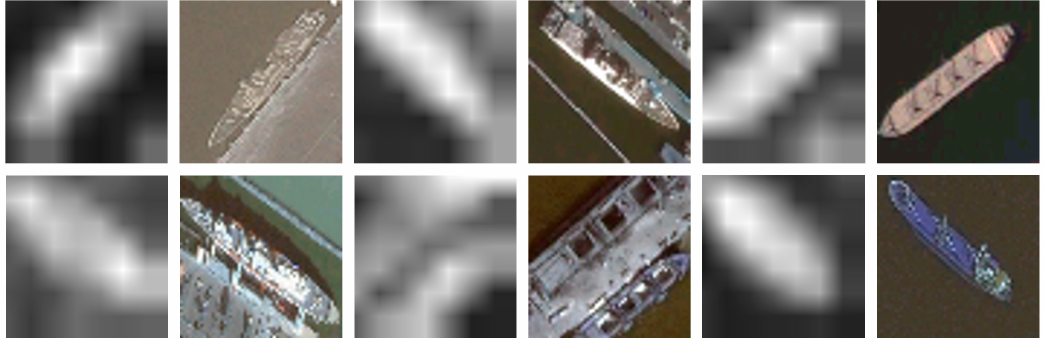
Figure 7. Visualization of the Multiscale Region of Interest (ROI) Align. Semantic and spatial information is completely preserved. Odd columns are the feature maps of the objects, and even columns are the objects.